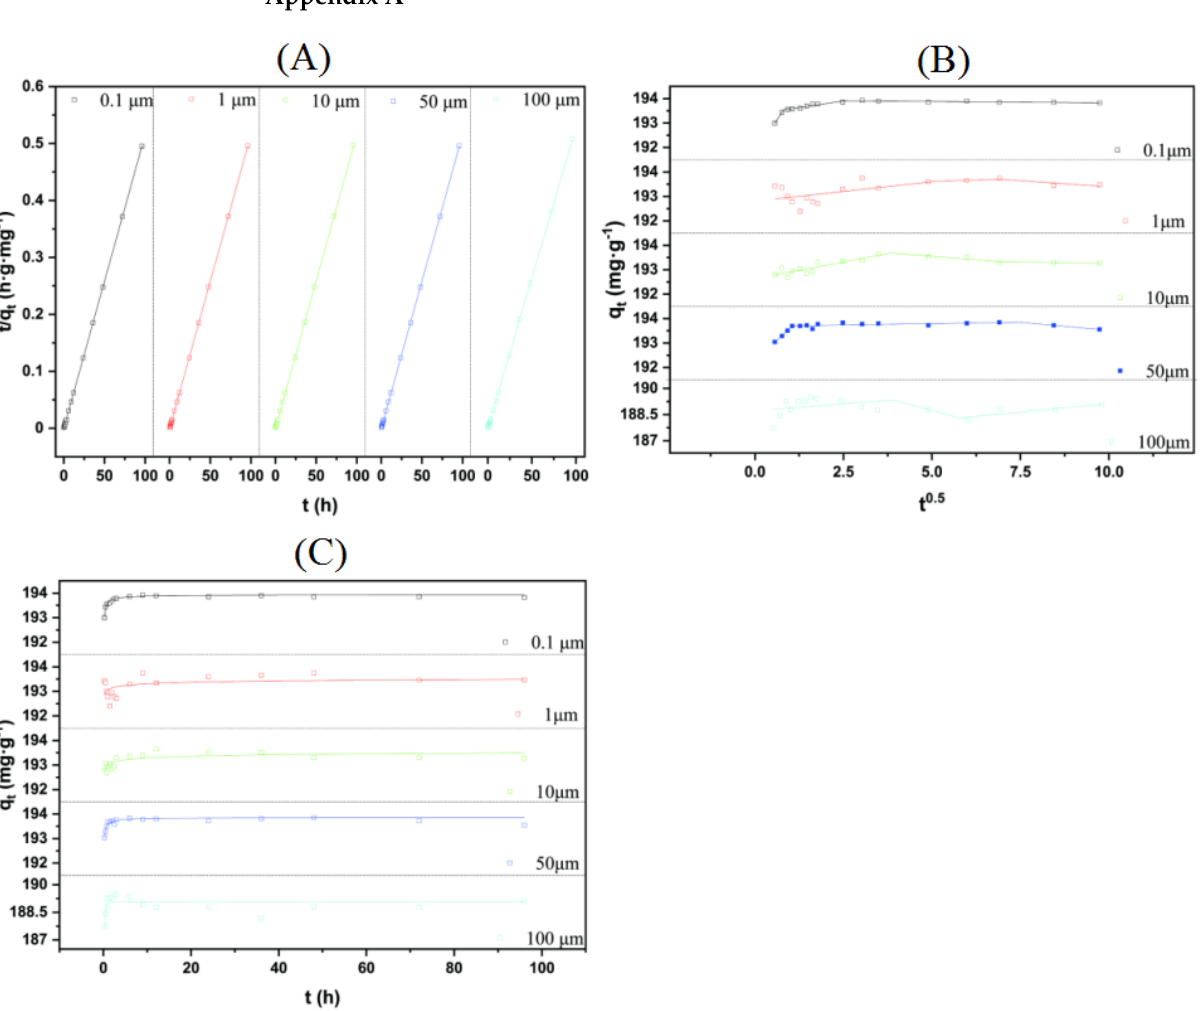
Figure A2. Adsorption isotherm model fitting of 20 μg/mL 0.1 μm of MPs−PS with different con- centrations of NP. ( A ) Langmuir model fitting. ( B ) D−R model fitting.